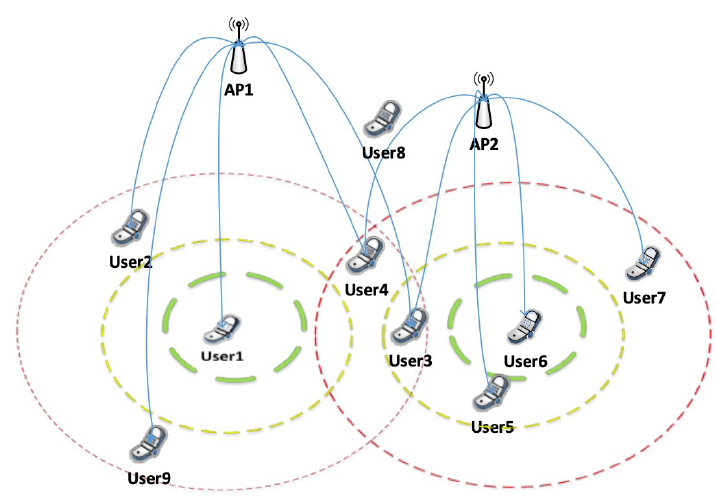
Figure 4. Different signal strengths divide the coverage